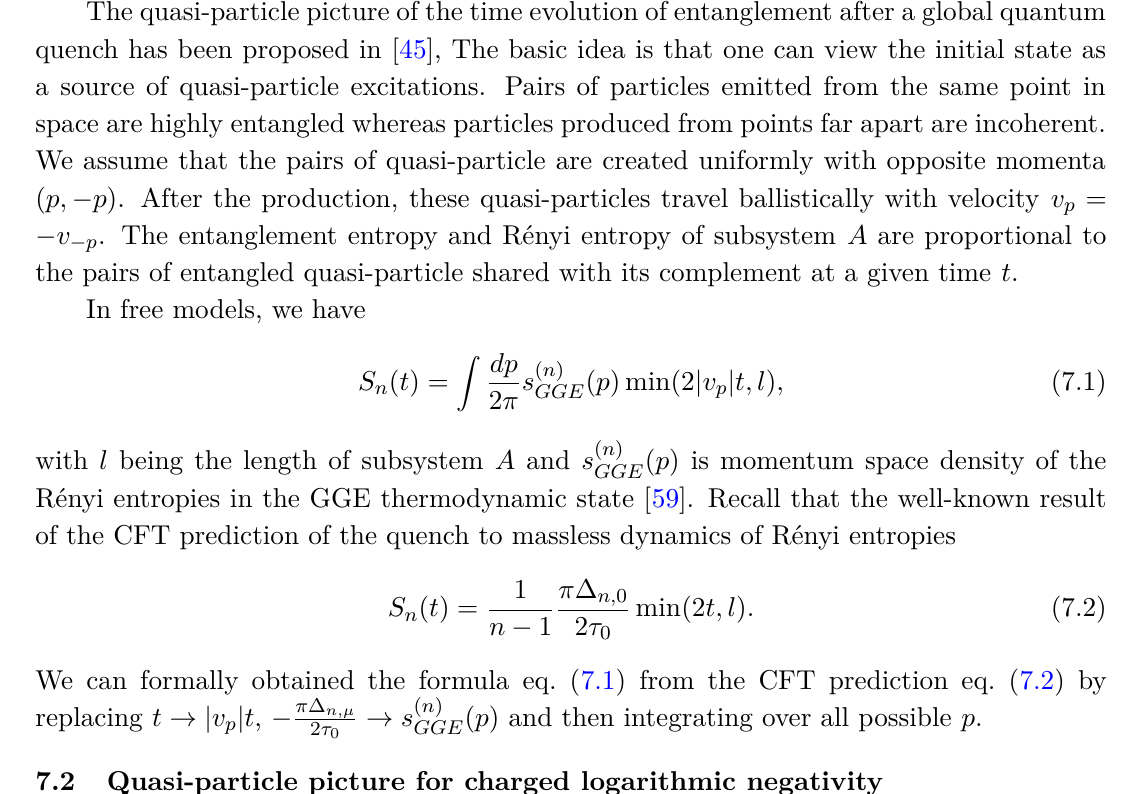
Figure 2 . Numerical data of charged logarithmic negativity E ( µ ) as a function of t/l for µ = π in the complex harmonic chain. The full lines are the CFT predictions (cf. eq. (4.10) and eq. (4.15)). Left panel: adjacent interval with L = 2000 , l 1 = 200 , l 2 = 250 . Right panel: disjoint interval with L = 5000 , l 1 = 250 , l 2 = 400 , d = 100 . We have used the best fitted value of τ 0